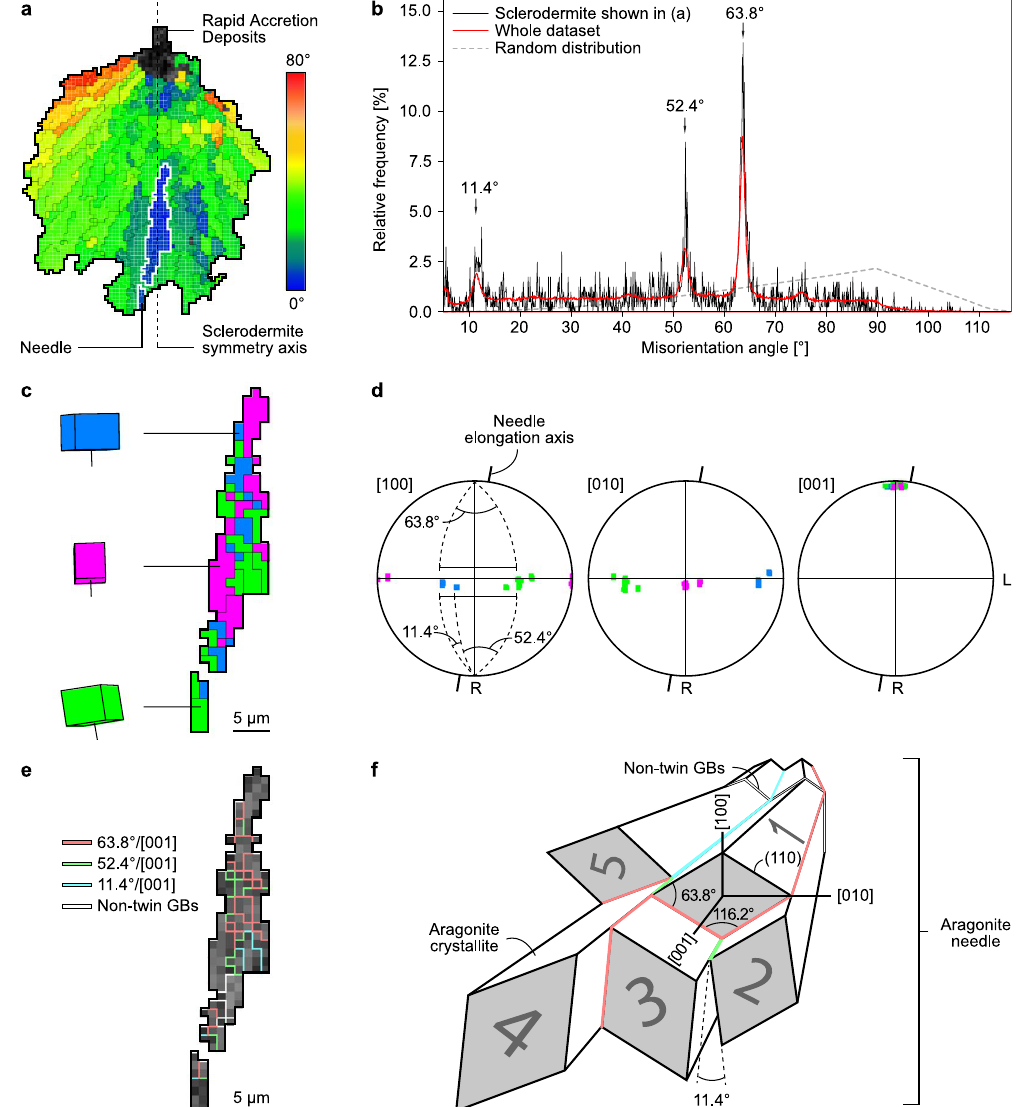
Figure 3. Crystallographic anatomy of sclerodermites. ( a ) EBSD cumulative misorientation map of the sclerodermite outlined in Fig. 2 showing the orientation of aragonite [001] axes with respect to the sclerodermite symmetry axis (dashed line). Only standard (i.e. non-twin) grain boundaries delimiting domains with misorientations > 10° are indicated for clarity. The needle outlined in white has been selected for further investigation. ( b ) Diagram showing the non-random distribution of misorientation angles between the adjacent crystallites of the sclerodermite shown in ( a ). High relative frequencies are observed for misorientation angles of 11.4°, 52.4°, and 63.8°. ( c ) Trichromic EBSD map of the aragonite needle outlined in (a) illustrating the approximate orientation of the aragonite unit cell and [001] axes. ( d ) Pole figures of the needle shown in ( c ) displaying the strong clustering of aragonite [001] axes close to the needle elongation axis and the pseudo- hexagonal misorientation of [100] and [010] axes in a plane oriented normal to R. Pole figures are represented on lower hemisphere equal area projections. The radial and longitudinal growth directions of the corallite are indicated by R and L, respectively. Colour code as in ( c ). ( e ) EBSD twin boundary map of the needle shown in ( c ) displaying the misorientation angle/axis pairs between adjacent crystallites. Most of the grain boundaries are twin boundaries delimiting crystallites characterized by misorientations of 11.4°, 52.4°, and 63.8° around [001]. Note that non-twin grain boundaries are located in the bent section of the needle. ( f ) Sketch illustrating the angular and facial relationships between pseudo-hexagonally twinned crystallites within an aragonite needle. Misorientation angles between grains 1 & 2, 2 & 3, and 1 & 5 are 63.8°, 52.4° and 11.4°, respectively. Colour code as in ( e